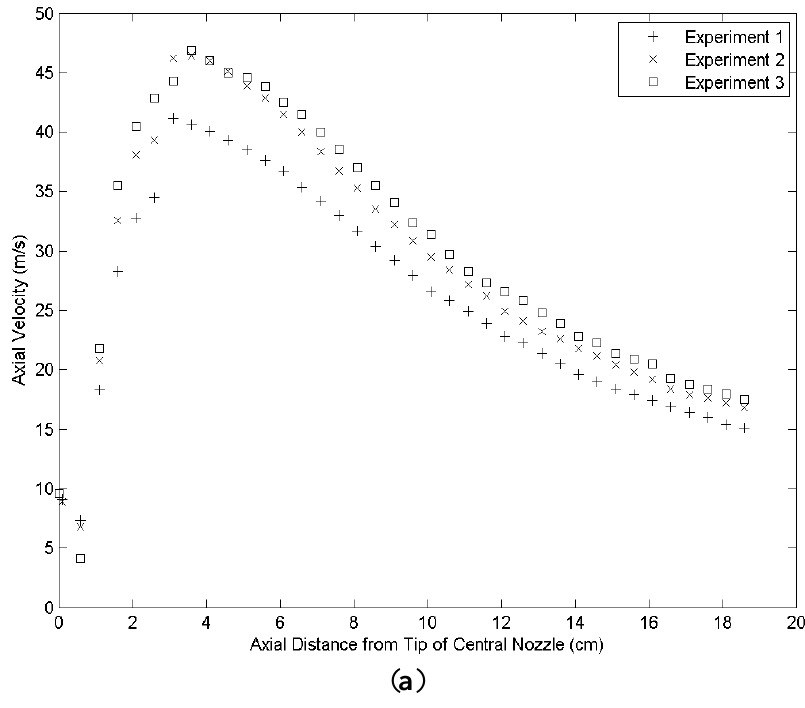
Figure 8. Plots of centerline traverses ( a ) Axial velocity vs. distance from origin of annular jet for Experiments 1, 2, and 3; ( b ) Static pressure vs. distance from origin of central jet for Experiments 1, 2, and 3; ( c ) Static pressure vs . distance from origin of central jet for Experiment 2 with and without PA jet